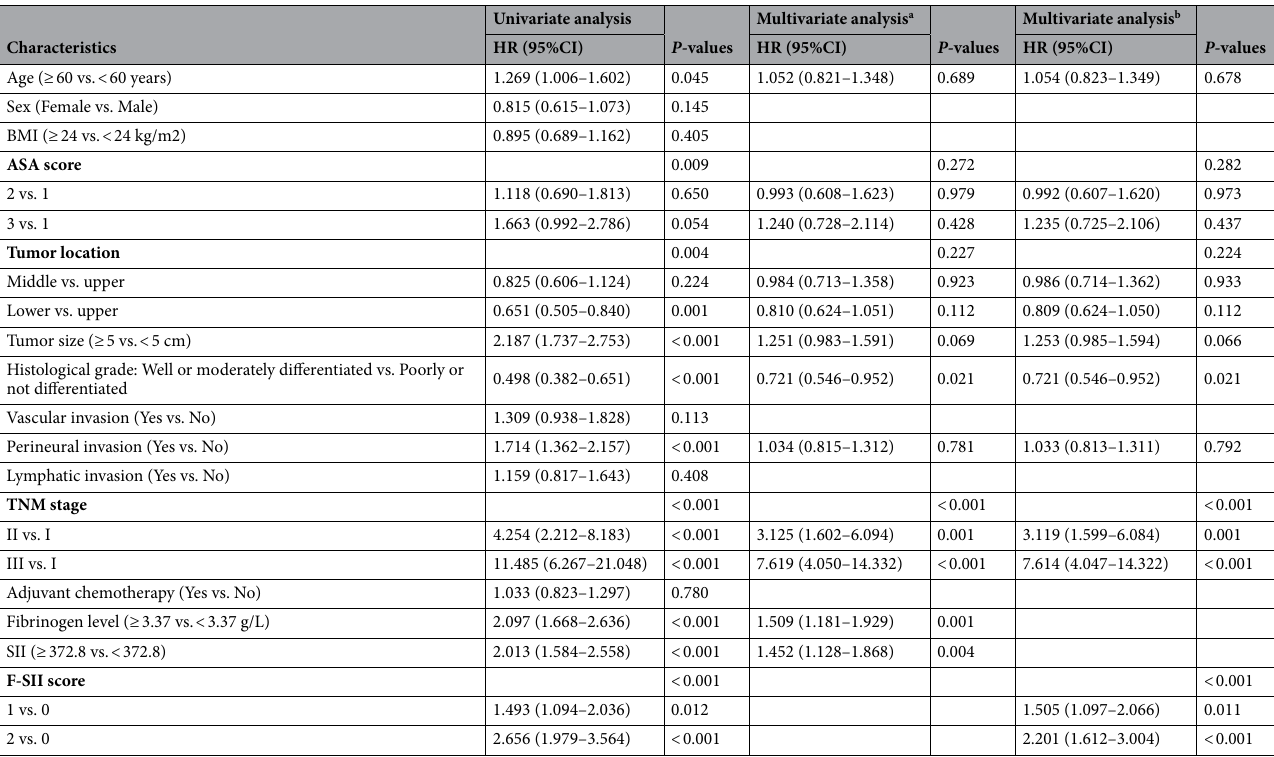
Table 2. Univariate and multivariate Cox regression analyses for overall survival in patients with gastric cancer. BMI Body Mass Index, ASA score American Society of Anesthesiologists score, SII Systemic immune-inflammation index, F-SII score Fibrinogen and systemic immune-inflammation index score. a Adjustment for all variables listed in the table, except for sex, BMI, vascular invasion, lymphatic invasion, chemotherapy, and F-SII score. b Adjustment for all variables listed in the table, except for sex, BMI, vascular invasion, lymphatic invasion, chemotherapy, fibrinogen level, and